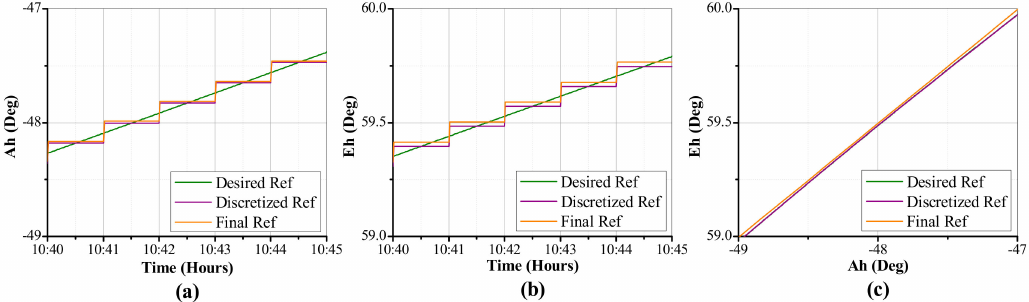
Figure 16. Setpoint of the orientation control for the azimuth angle ( a ), the elevation angle ( b ), and both angles ( c ).